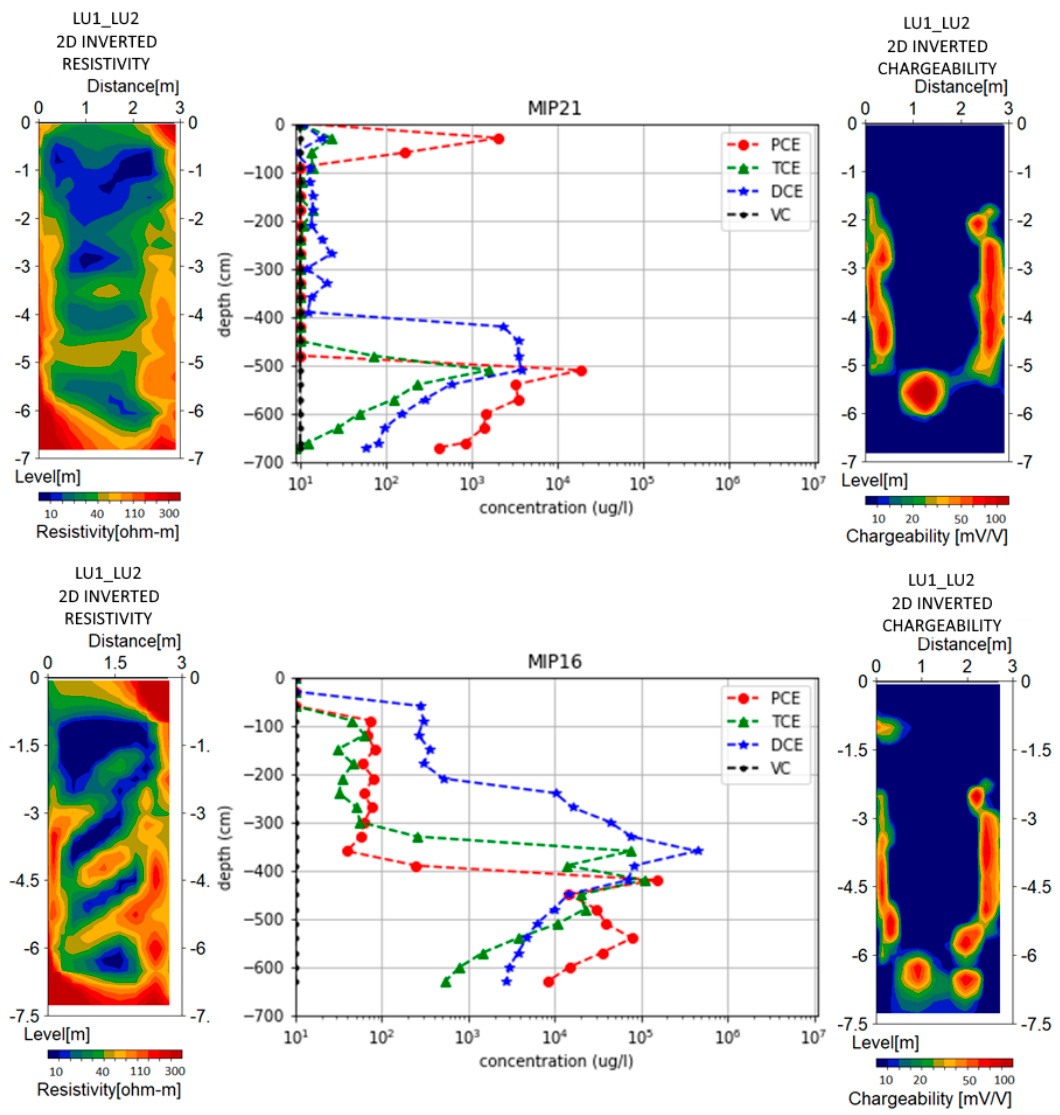
Figure 8. Cross-hole tomography results for resistivity ( left ) and time-domain chargeability ( right ) in comparison with the respective concentrations from the MIP sounding (middle [28]) for LU1-LU2 (top) and LU6-LU7 (bottom). The locations of the boreholes can be seen in Figure 3.